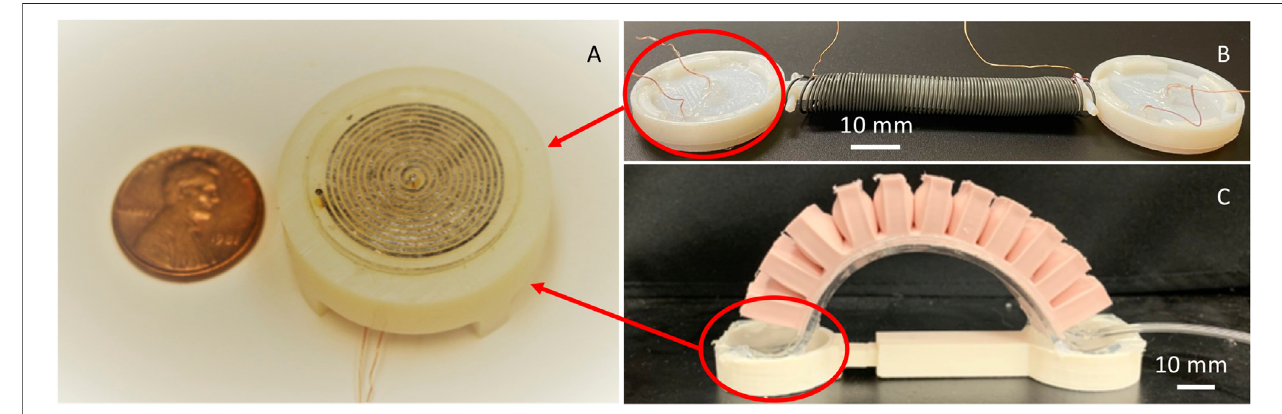
FIGURE1|(A) Close-up viewofthecomposite pad withtunableCoF (B) Thesoftcrawlinginchworminspiredrobot withtwocompositepads at theends. (C) The soft crawling earthworm inspired robot with two composite pads at the ends.